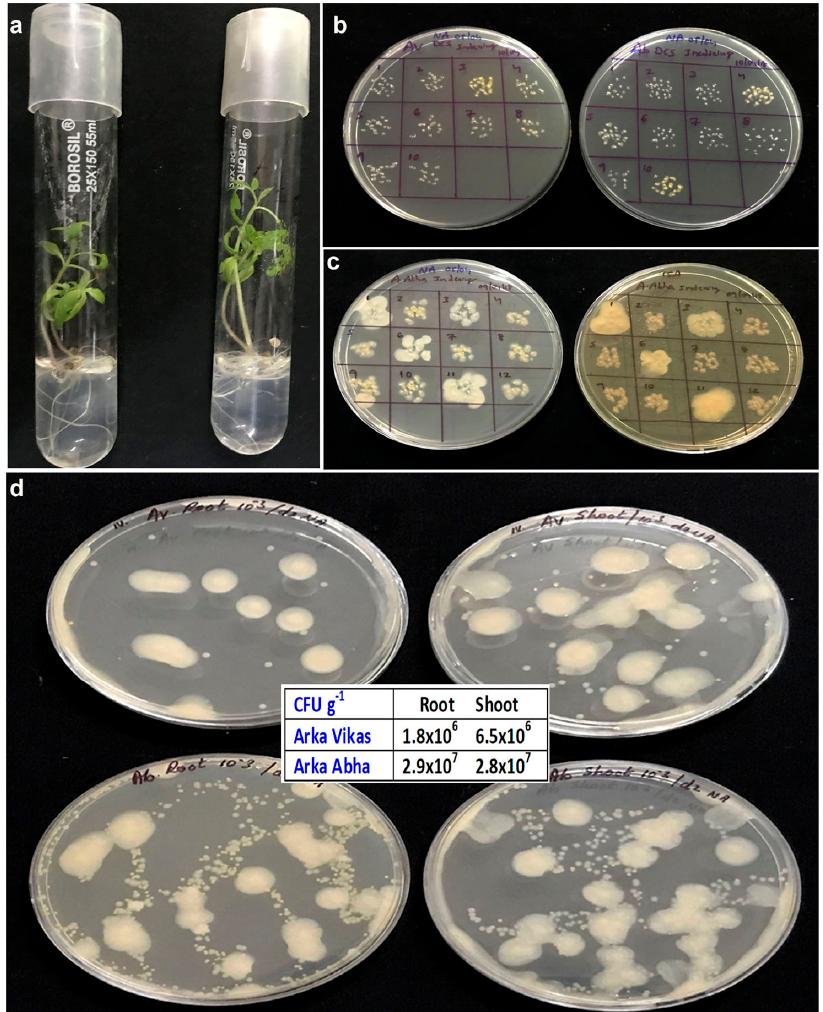
Figure 1. Indexing of visibly clean tomato seedling cultures for bacterial association and the isolation of associated bacteria. ( a ) One month old visibly clean in vitro seedlings of tomato “Arka Vikas” and “Arka Abha”, ( b ) indexing of seedling cultures at two weeks from initiation showing bacterial association in 10–30% cultures on nutrient agar (NA) after overnight incubation, ( c ), indexing of 4 week old “Arka Abha” seedlings on two media (NA and trypticase soy agar (TSA) showing the association of different bacteria 3 days after the indexing, ( d ) bacterial cfu from shoot and root tissues of one-month old “Arka Vikas” and “Arka Abha” seedlings displaying different colony types.